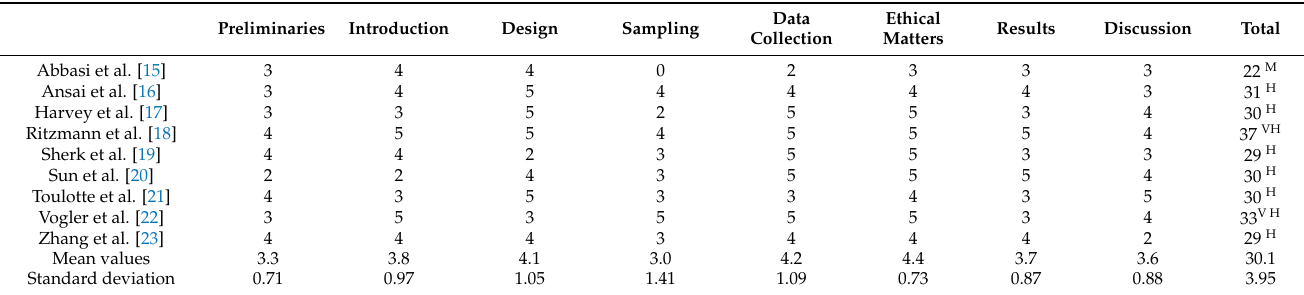
Table 2. Results of the CCAT quality